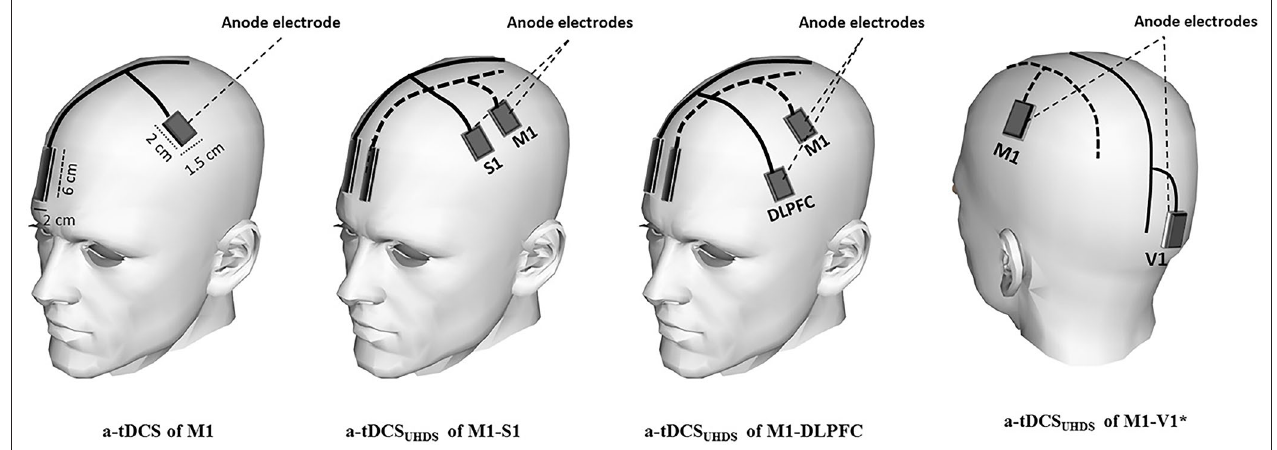
FIGURE 1 | Schematic illustration of electrode montage in conventional a-tDCS and a-tDCS UHCDS ; the active electrodes were positioned over M1, dorsolateral prefrontal cortex (DLPFC), S1, and V1. The reference electrodes were placed over the contralateral supraorbital area in all conditions. In the sham condition, the electrodes were placed in the same positions as for M1-S1 or M1-DLPFC stimulation. ∗ The reference electrodes are not shown in a-tDCS UHCDS of M1-V1.